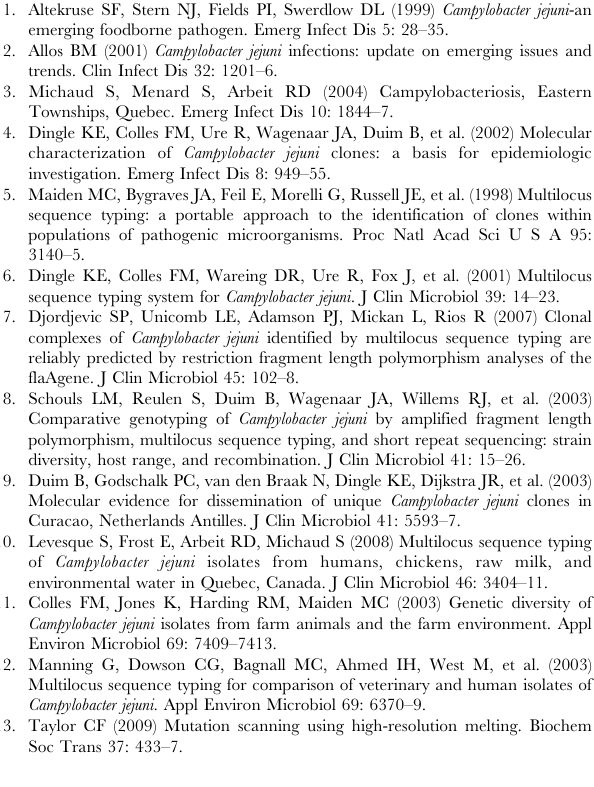
Figure 2. Data preparation for HRM. A : Amplification curves for tkt right fragment for 96 isolates. B : Normalization of raw melting curve data. Green box: pre-melt (initial fluorescence). Blue box: post-melt (final fluorescence). C : Normalized and shifted melting